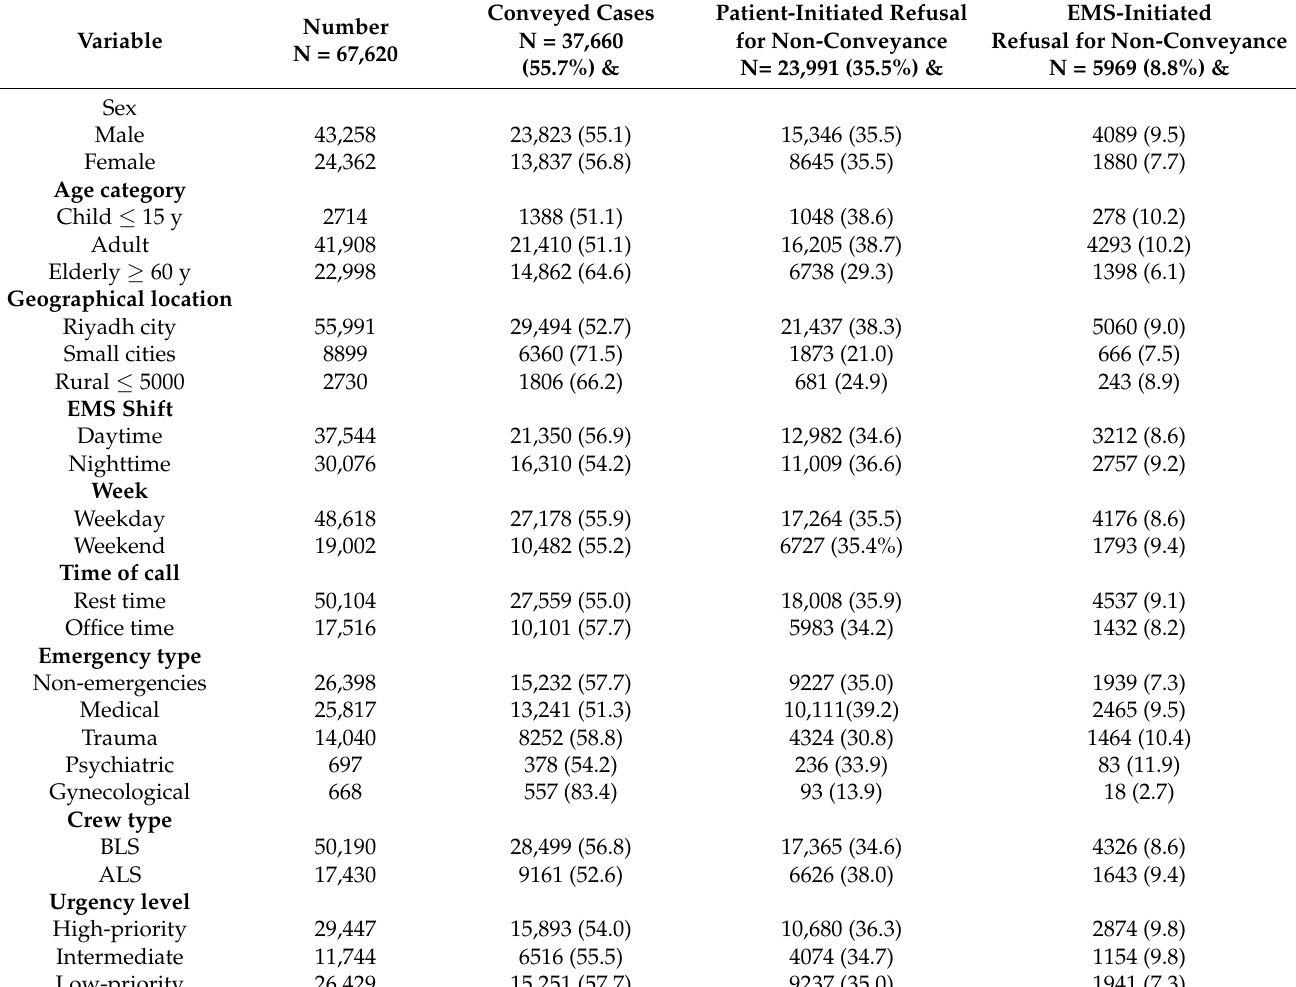
Table 1. Characteristic feature of demographic, operational factors for 67,620 missions dispatched at the scene.